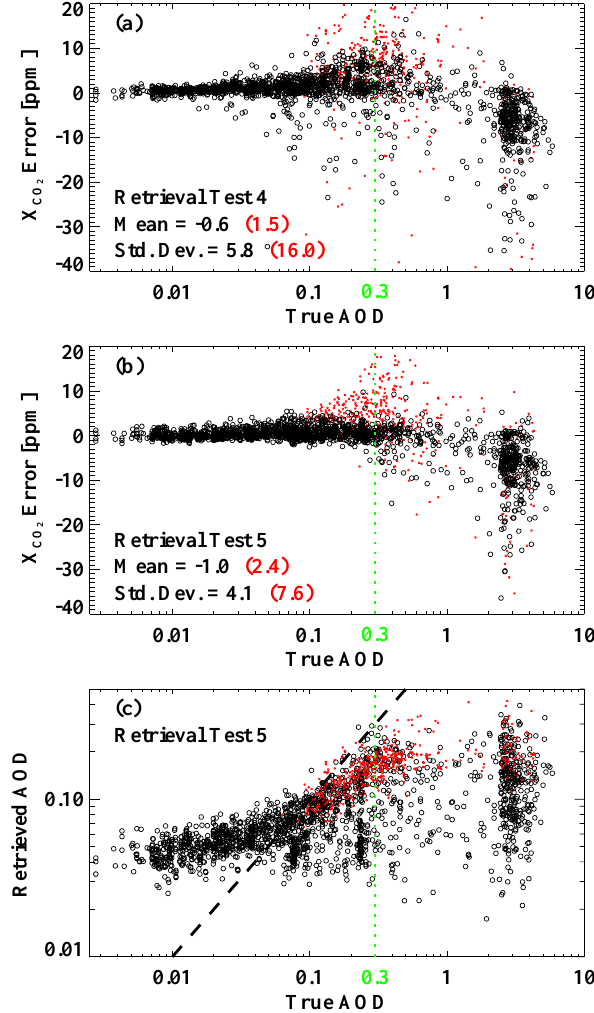
Fig. 8. (a) Retrieved X CO error versus true AOD for test 4. Black 2 circles denote converged retrievals which passed the cloud filter; red dots denote converged retrievals which failed the cloud filter. The corresponding mean and RMS X CO errors in ppm are given in 2 the lower left. The green, vertical dashed line denotes the original 0.3 AOD threshold for retrievals identified in Crisp et al. (2004). Note that a few soundings with AOD > 0.1 have errors larger than the plotted ordinate range. (b) Same as panel (b) , but for test 5. (c) The retrieved AOD versus true AOD in test 5. The one-to-one line (dashed) is shown for